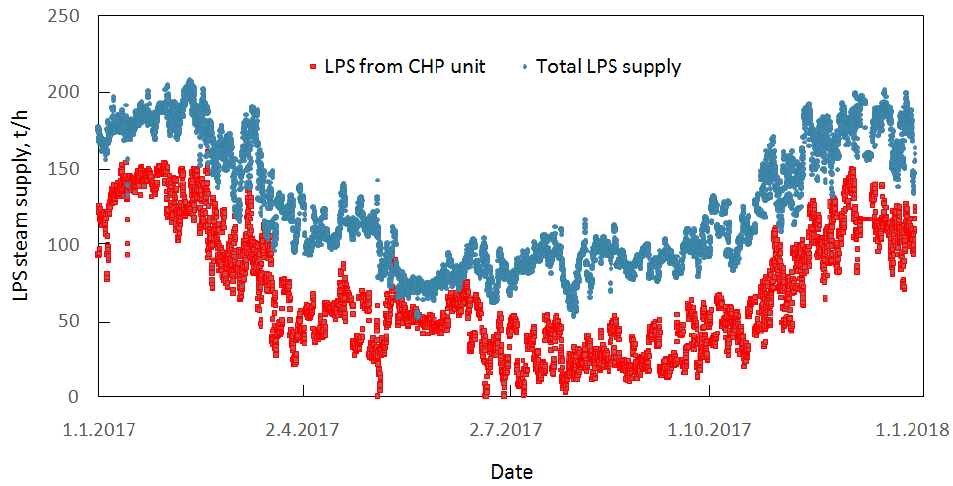
Figure 5. A time course of LPS steam supply from the CHP unit and its total supply throughout the year 2017.